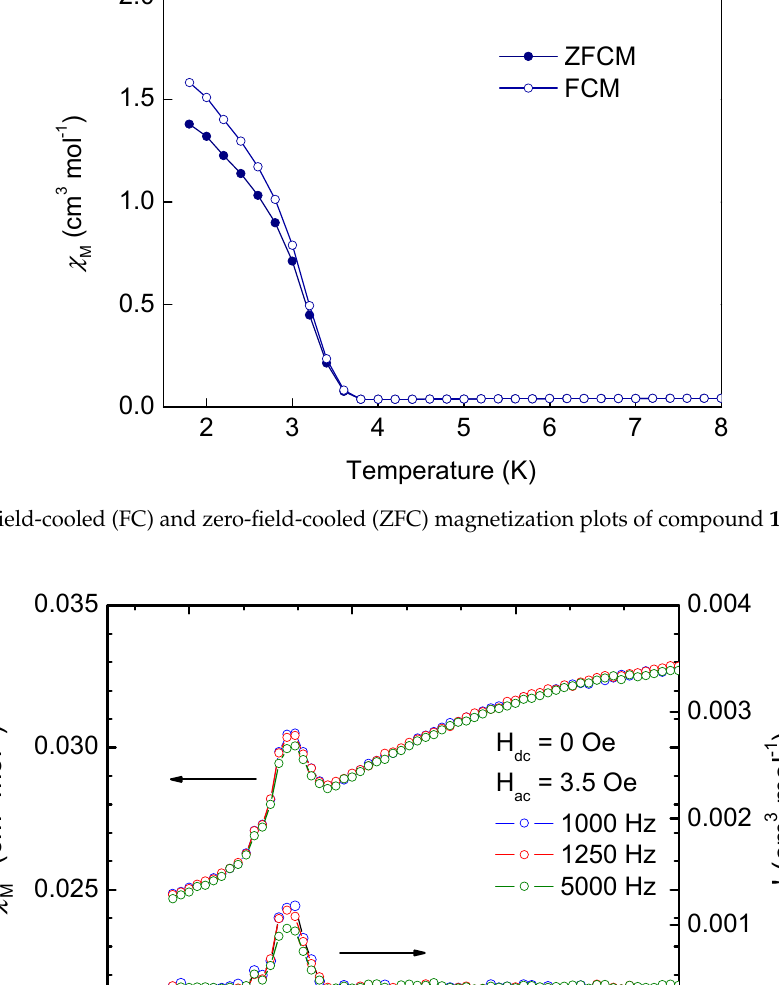
Figure 6. Plots of χ M T vs. T of compound 1 measured under different external fields.